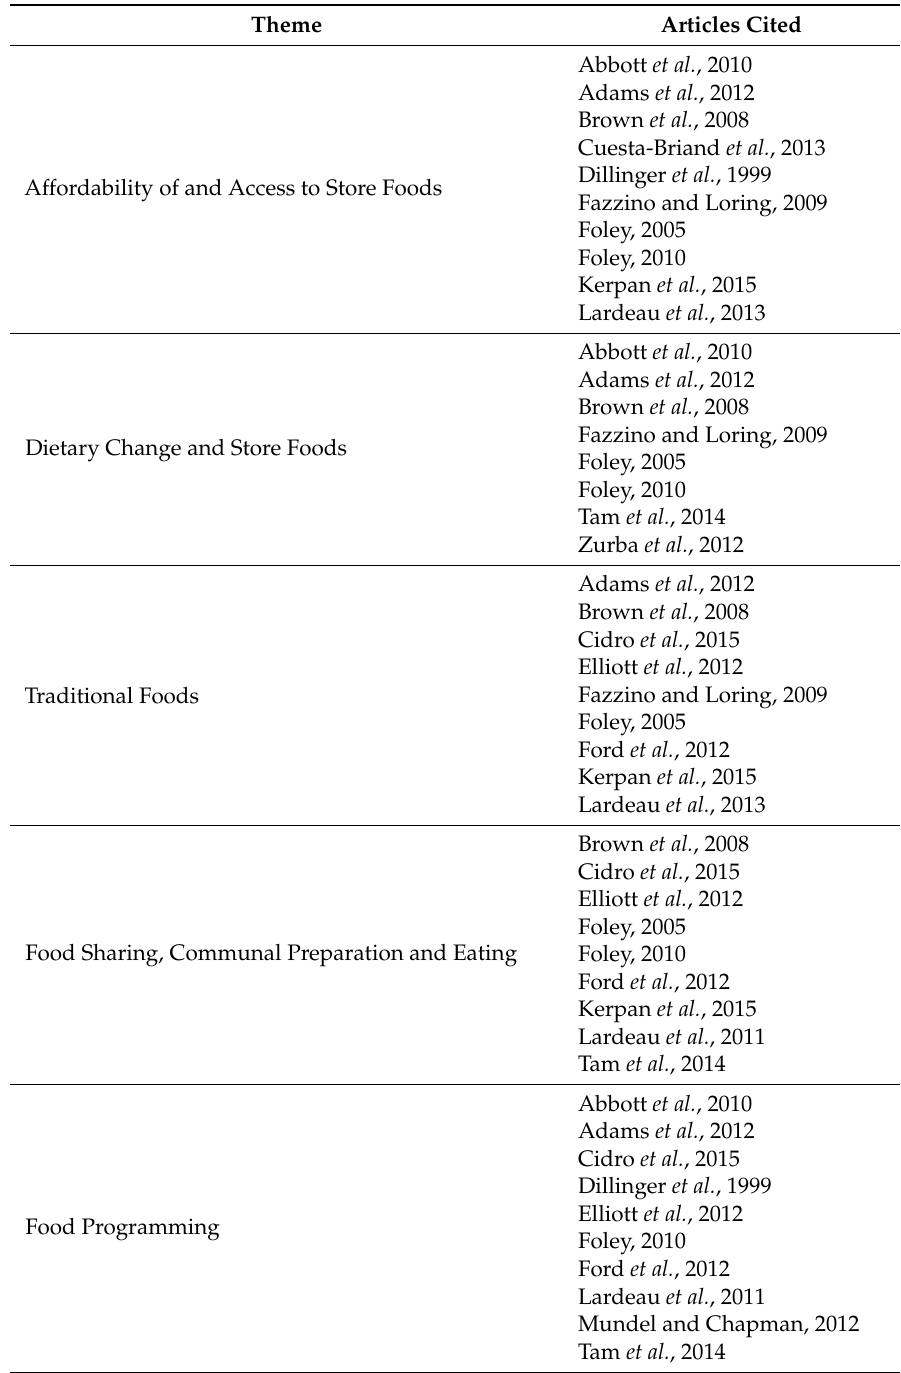
Table 2. Articles cited by